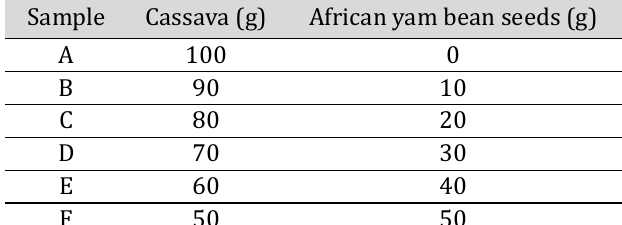
Table 1. formulation of cassava: African yam bean